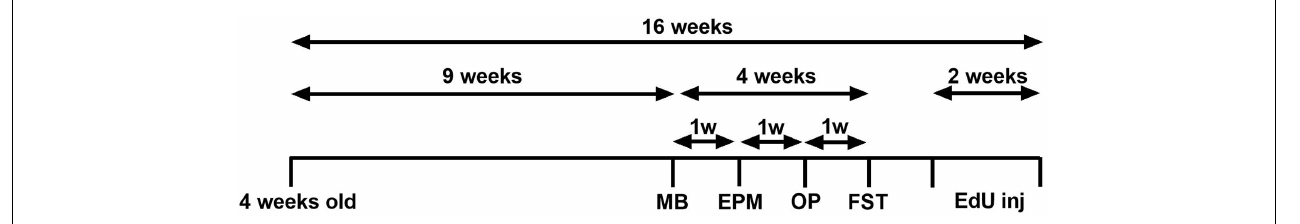
FIGURE 1 | Experimental design of the study. Experimental design of the anxiety-related and depression-related marble burying (MB), elevated-plus-maze (EPM), open-field (OF), and forced swimming test (FST). Animals consumed 5% sucrose in the DID paradigm for 9 weeks prior to each behavioural testing and continued to be exposed to sucrose for a total of 16 weeks. Behavioural tests were conducted 1 week apart (across 4 weeks) after 24 h of sucrose withdrawal. After 14 weeks of sucrose consumption (1 week after behavioural tests concluded), three EdU injections were administered over 2 weeks (days 0, 7, 14). Animals were assigned into two groups: sucrose-withdrawn animals and water